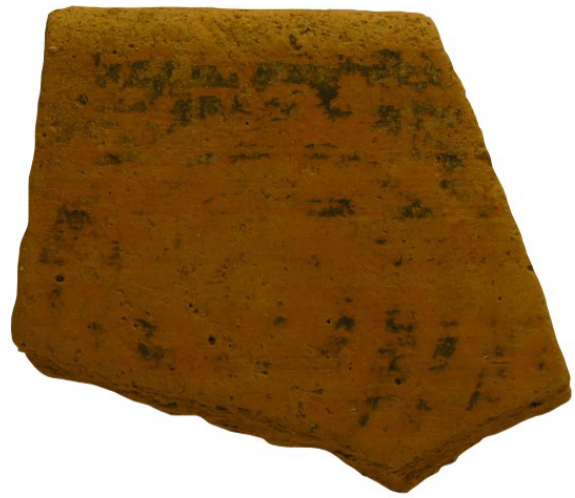
Figure 18. Black Slip Bichrome II plate, AIS 0588.008, W. 4.6 cm, ©